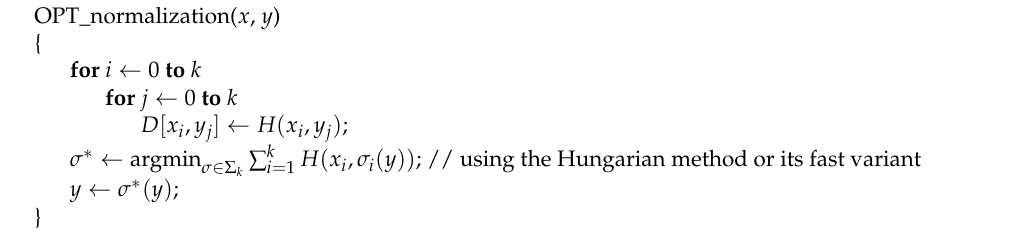
Figure 7. Pseudocode of normalization by the optimal